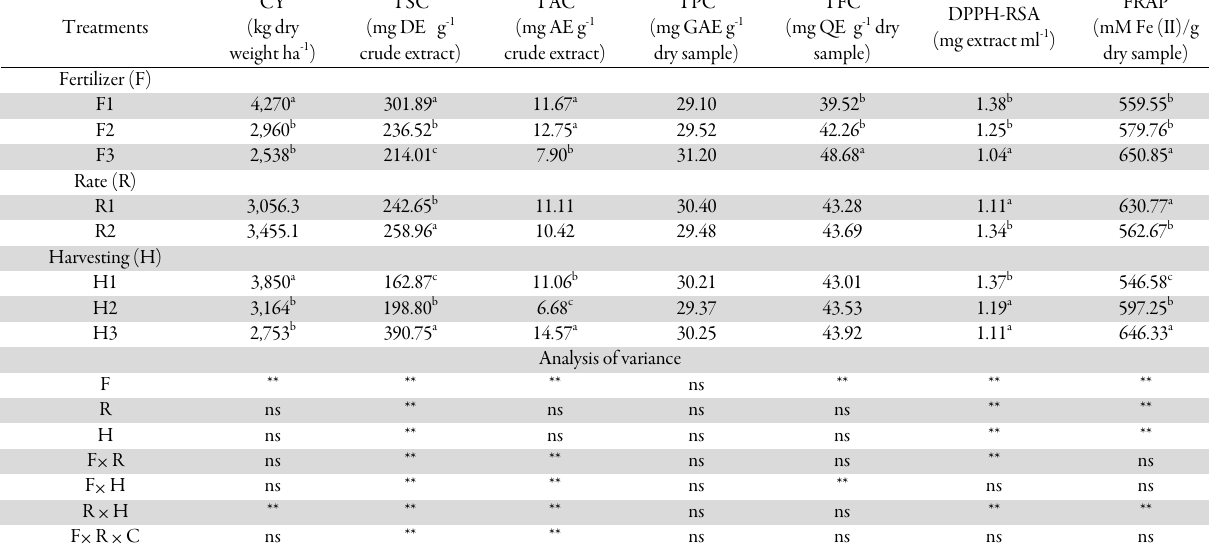
Table 1. Effects of fertilizer application and successive harvesting on yield, total saponin, total alkaloid, total phenolic and total flavonoid contents and antioxidant activity of Cynodon dactylon Treatments